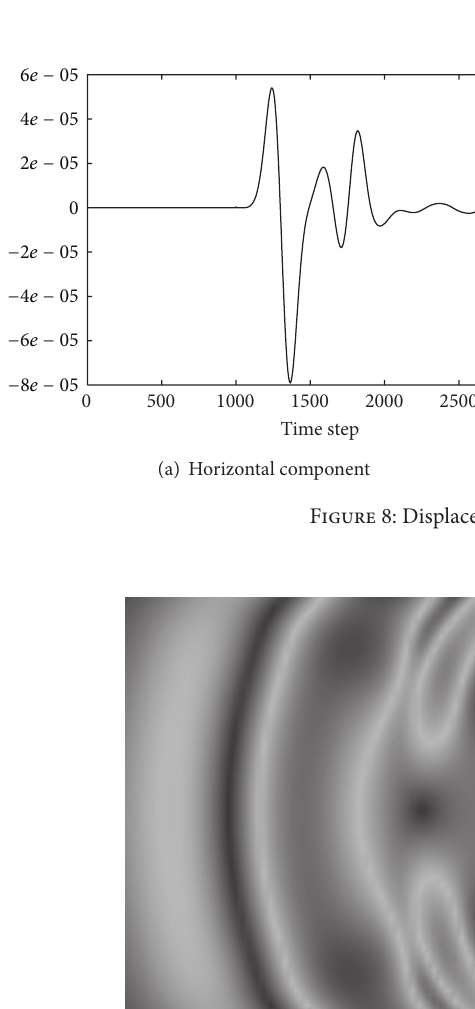
Figure 7: Acoustic potential observed at the point (0.7,0.5) .